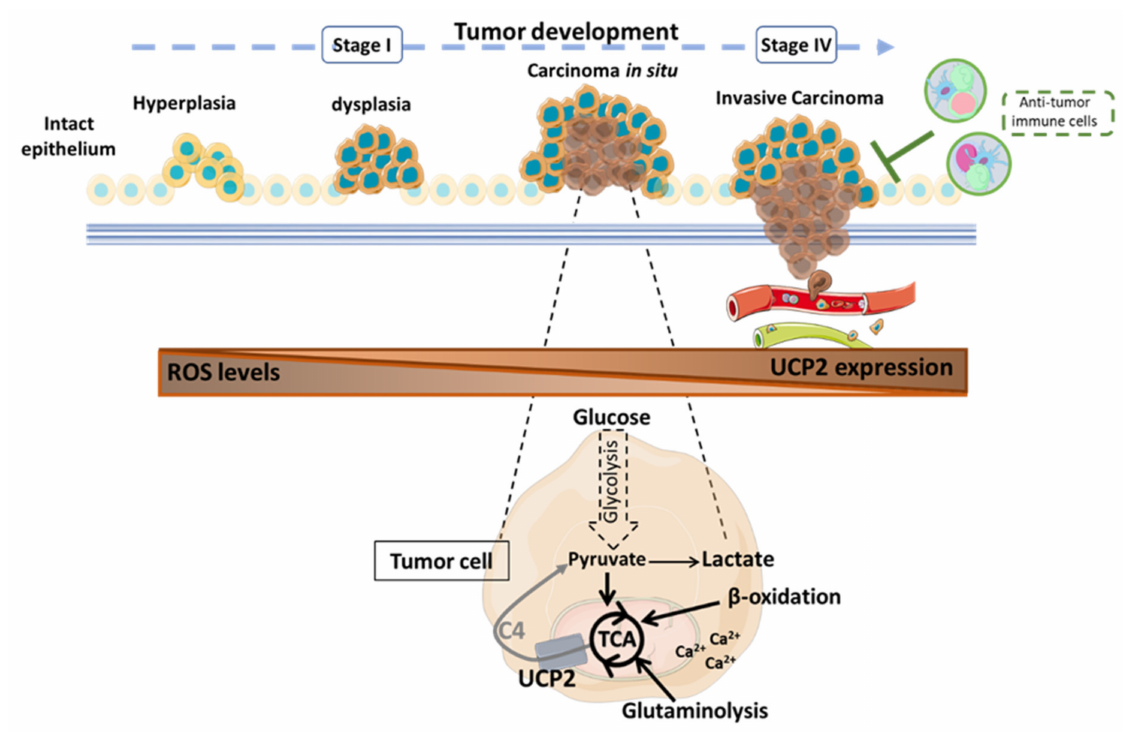
Figure 2. Role of the mitochondrial carrier UCP2 in tumor progression according to published results [32,111,114,116,117,147]. UCP2 is involved at all stages of tumor development with differ- ent consequences depending on the type of cancer. UCP2 acts as an antioxidant to counteract the formation of cellular and mitochondrial reactive oxygen species that could then spread into the tumor microenvironment (TME) to promote the acquisition of new pro-tumor properties of the cells. Through the transport of 4-carbon metabolites of the tricarboxylic acid (TCA) cycle, UCP2 is involved in the regulation of tumor metabolism. When UCP2 is expressed, tumor cells undergo oxidative metabolic reprogramming. Thus, glucose is preferentially converted to pyruvate to support cellular anabolism through TCA cycle activity. In addition, the export of C4 metabolites prevents the overloading of the TCA cycle via the accumulation of intramitochondrial compounds and reduces redox pressure to limit ROS production. Moreover, β -oxidation and glutaminolysis can be promoted to sustain TCA. Calcium dependence also supports the energy requirements of tumor cells. Never- theless, the presence of UCP2 correlates with a significant antitumor immune infiltration to resist tumor development. C4: 4-carbon metabolites; Ca 2+ : calcium ion; ROS: reactive oxygen species; TCA: tricarboxylic acid cycle; UCP2: uncoupling protein